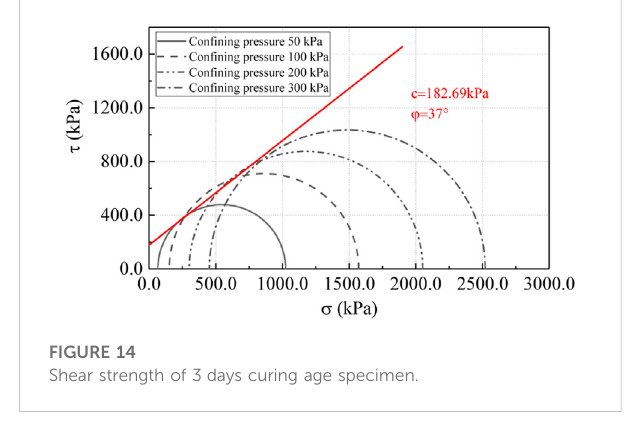
FIGURE 16 Triaxial shear test results with the growing of curing age.